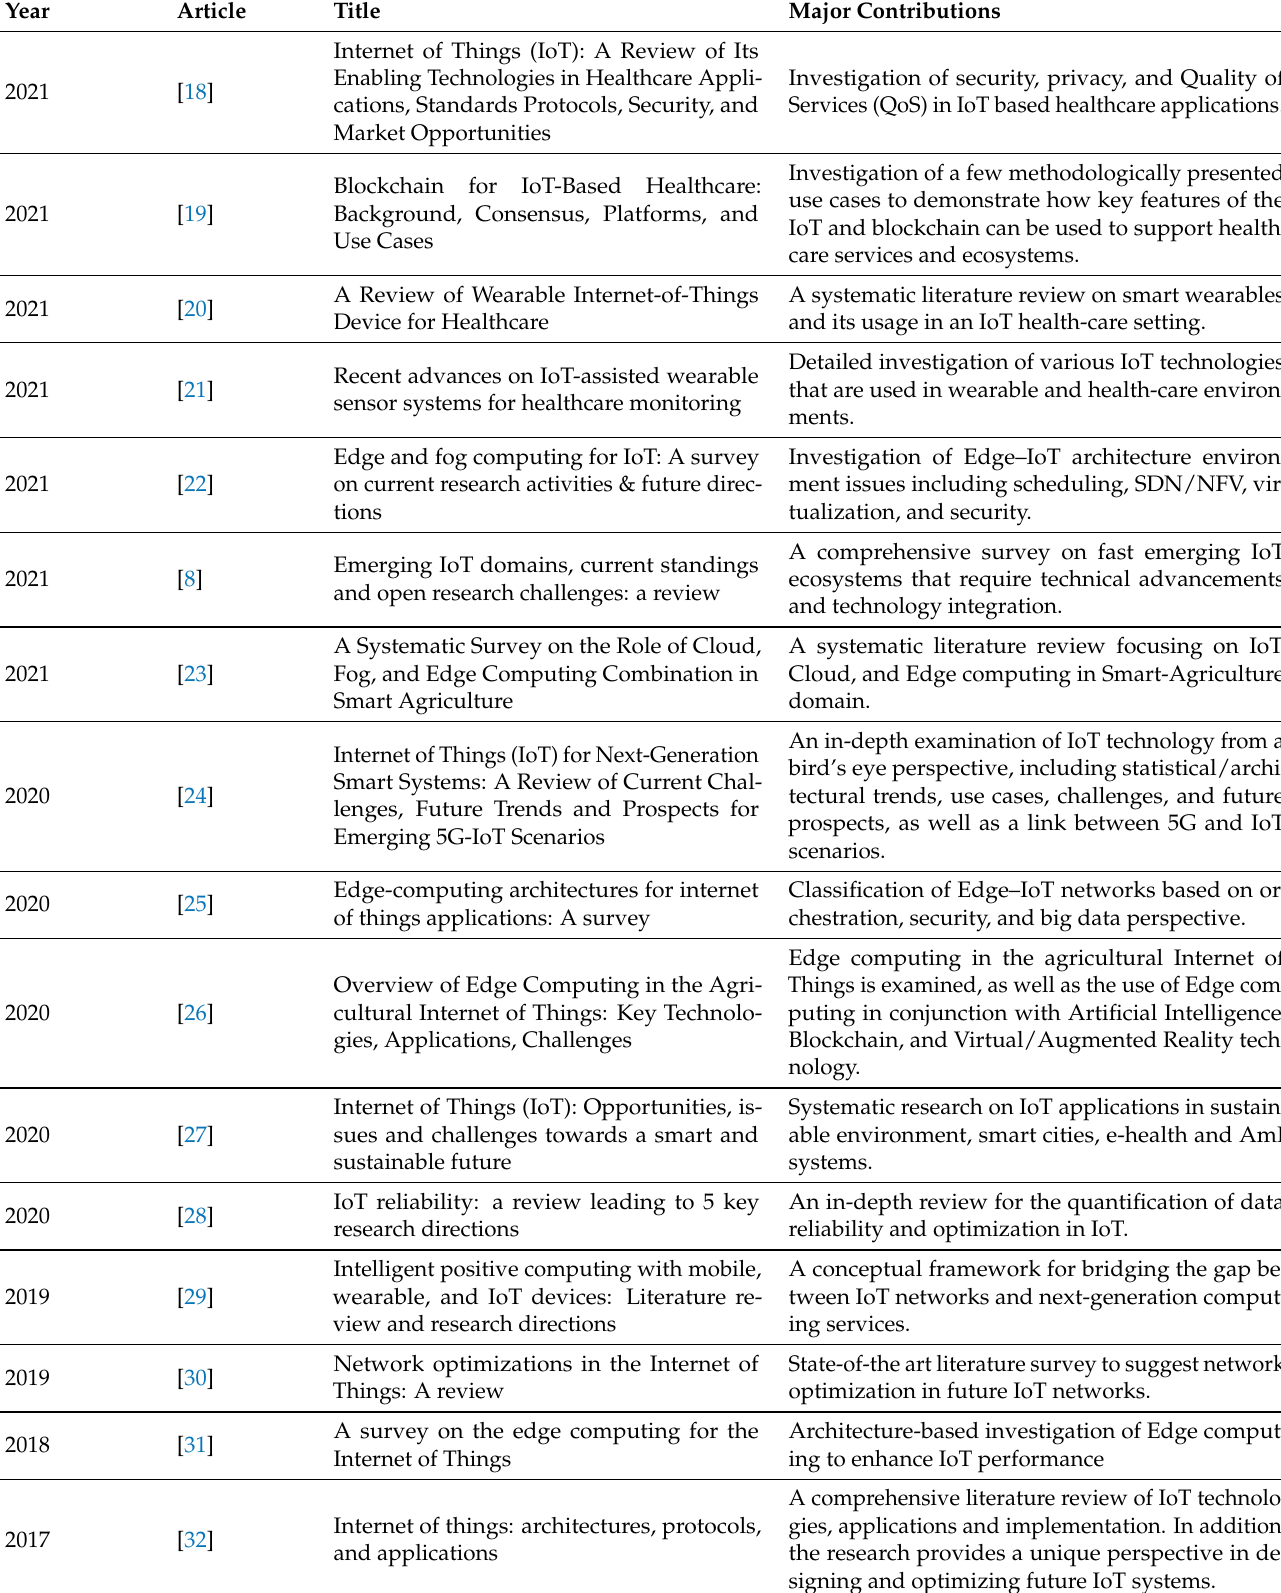
Table 1. Review/survey papers and their contributions in IoT application